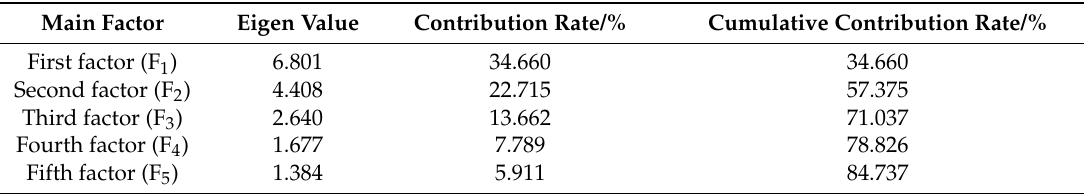
Table 3. Eigenvalues, contribution rate and cumulative contribution rate of main